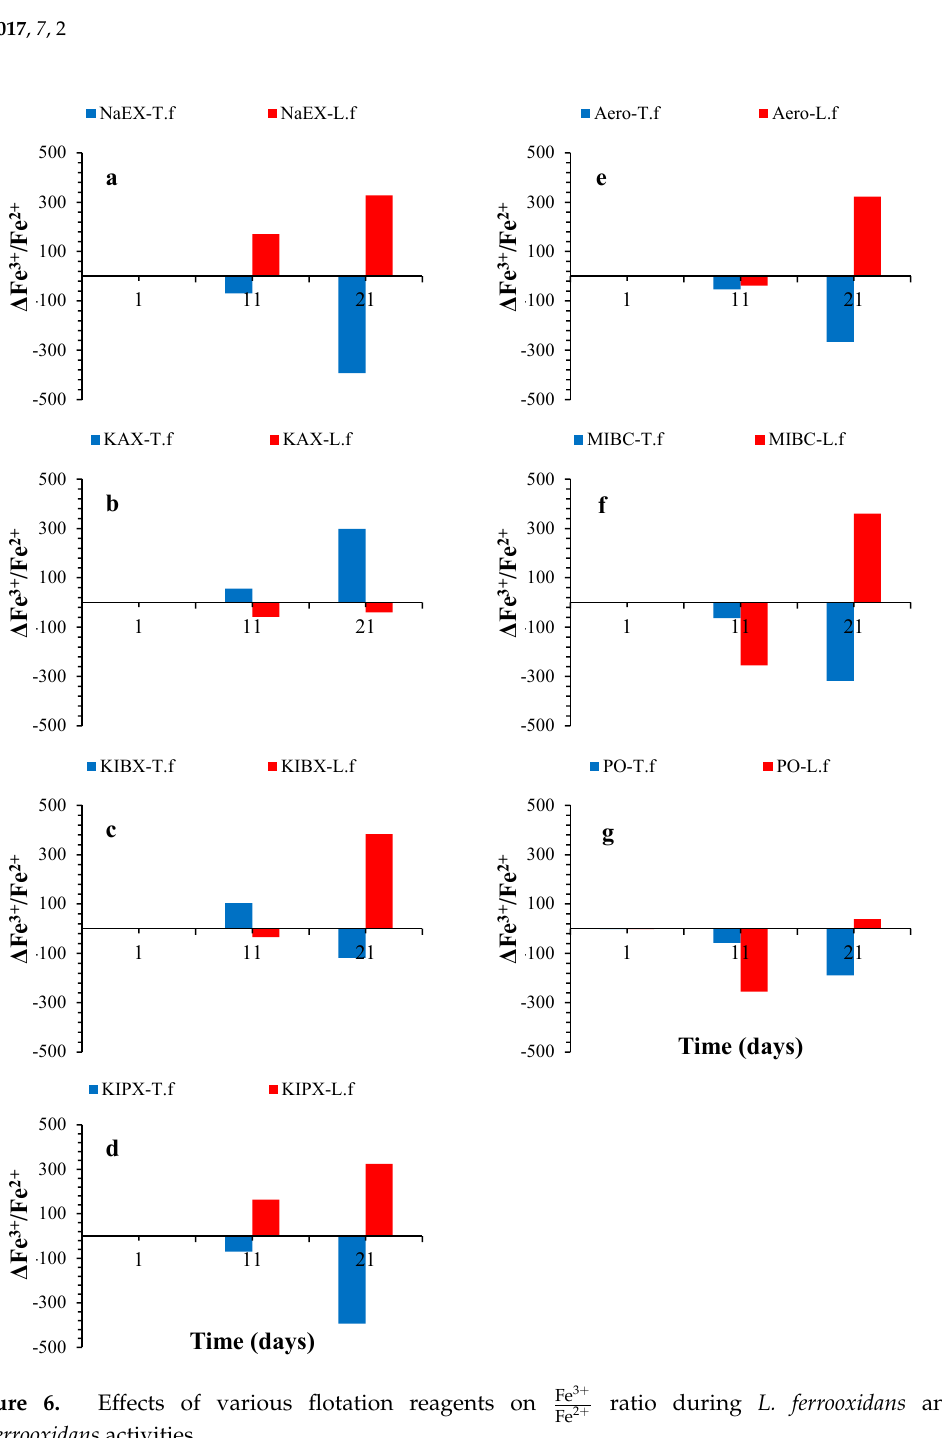
Figure 6 . Effects of various flotation reagents on (cid:2890)(cid:2915) Figure 6. Effects of various flotation reagents on Fe 3 activities.